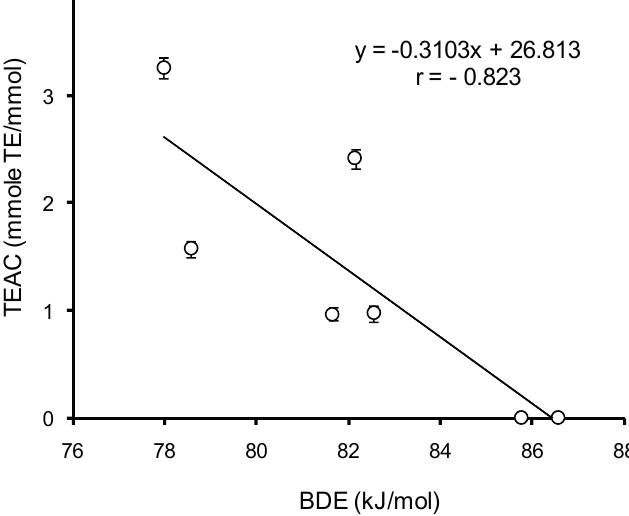
Figure 10. The correlation analysis of HB/HC acid AOC against the ABTS cation–radical at pH 3.5 versus values of bond dissociation enthalpy (BDE) in phenolic hydroxyl.